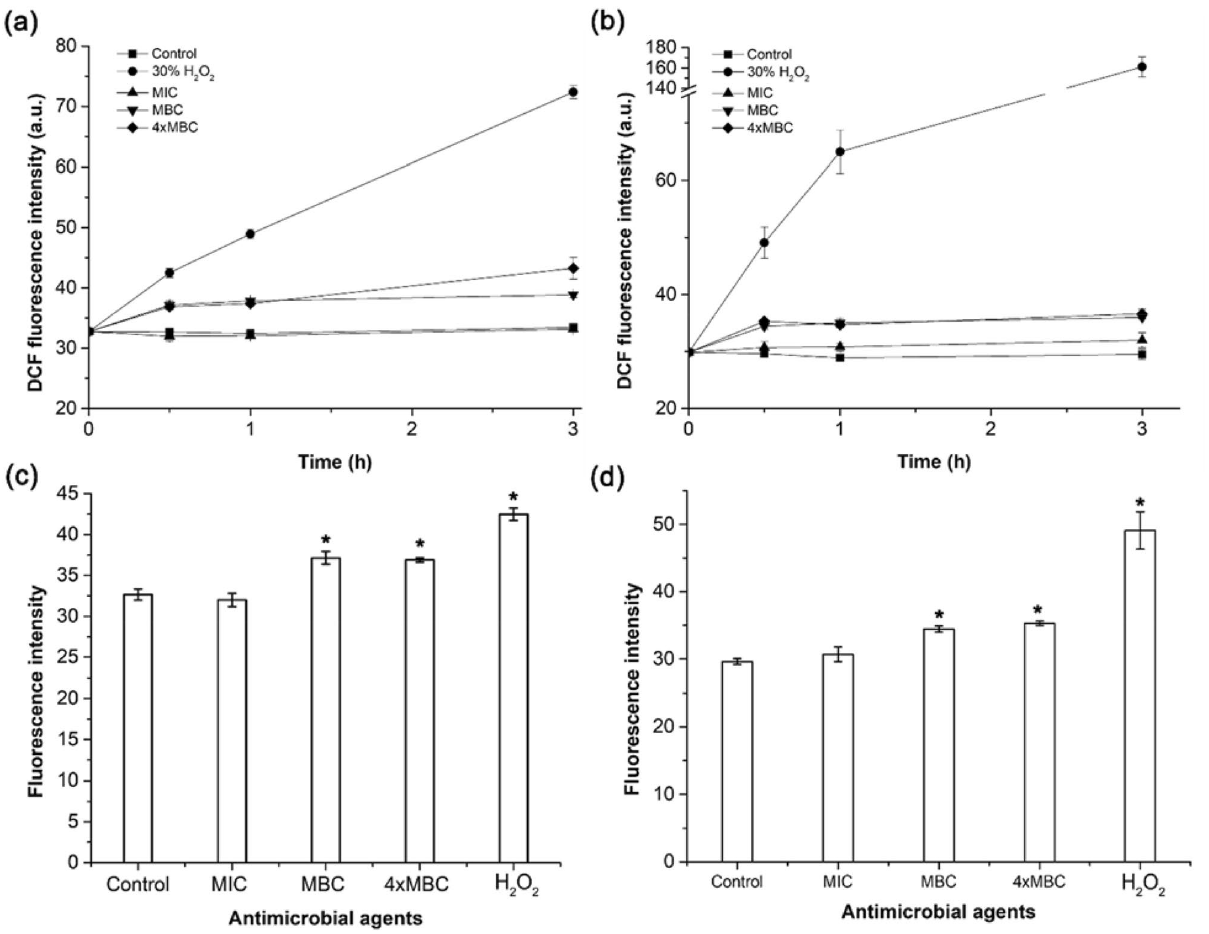
Figure 6. Kinetics of ROS induction in B. pseudomallei 1026b and E. coli O157:H7 after exposure to andro- AgNPs. All bacterial cells were treated with various concentrations of andro-AgNPs: 0 μg/mL (untreated control), MIC, MBC, and 4xMBC of AgNPs. 30% H 2 O 2 was used as a positive control. Kinetics of induction of ROS in B. pseudomallei 1026b ( a ) and E. coli O157:H7 ( b ) and accumulated ROS at 30 min ( c , d ) were followed by DCF fluorescence. An asterisk (*) indicates significant difference in ROS level in comparison with untreated control ( p < 0.01). Data represents the mean ± standard error from two independent experiments performed in triplicate (n =